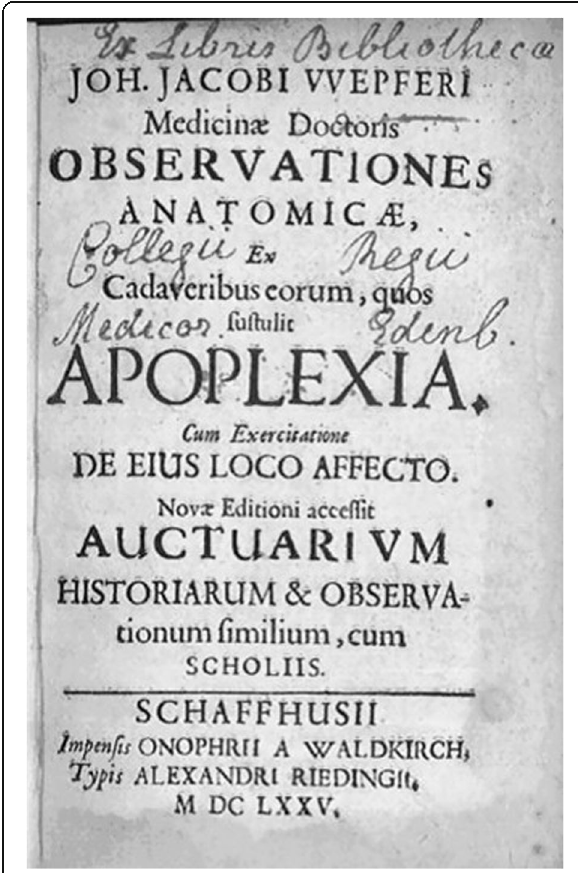
Fig. 5 Title page of Wepfer ’ s 1658 monograph on stroke. New